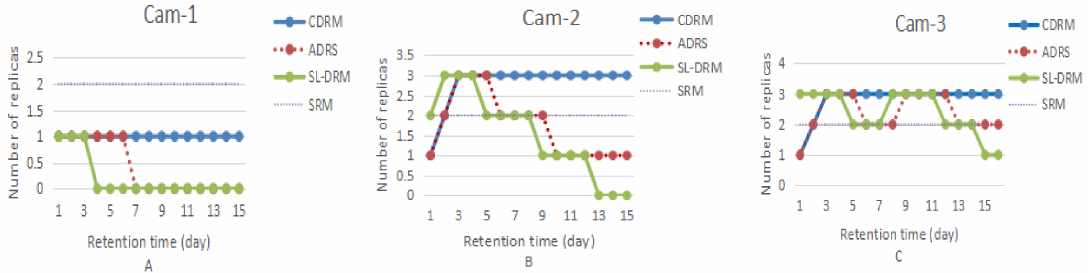
Figure 4. The first set of experiment data records.